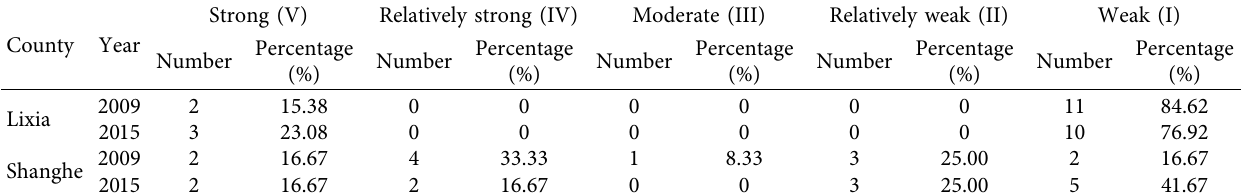
Table 3: Intensity level of